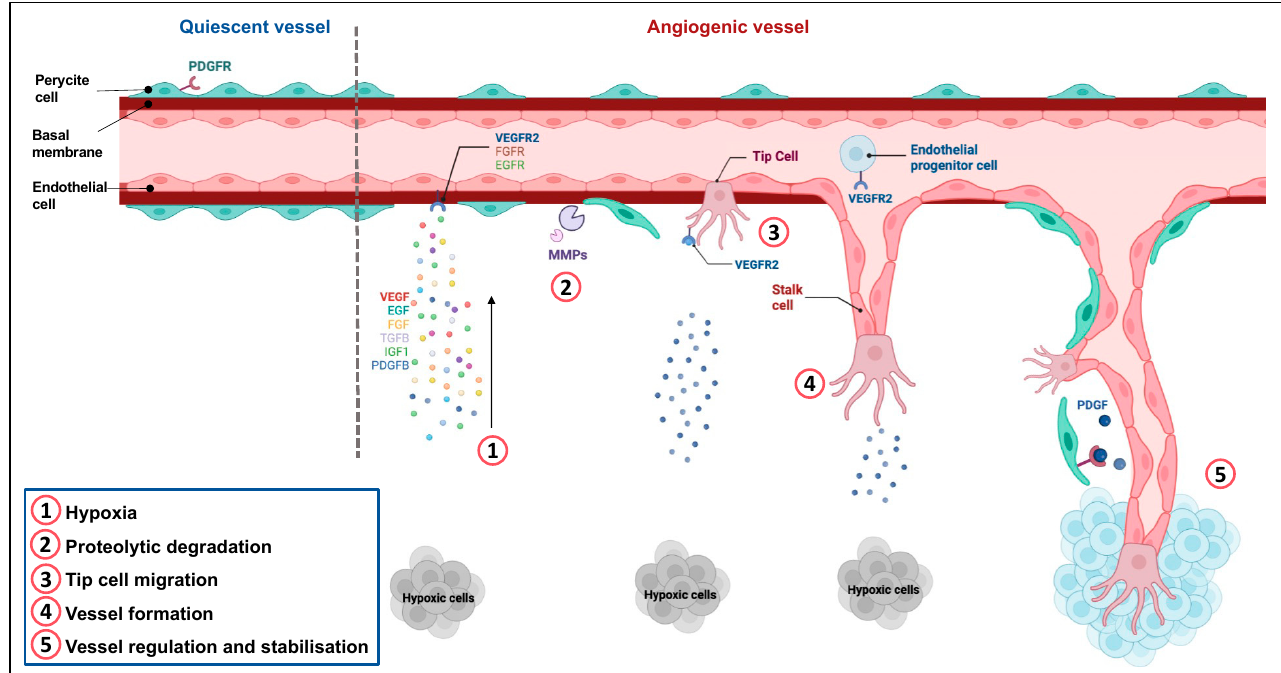
Figure 1. Regulation of angiogenesis. Quiescent ECs form a thin layer of single flat cells that line the interior surface of blood vessels and lymphatic vessels. These cells are interconnected by junctional molecules. EC monolayer is covered by pericytes, which control EC proliferation, release cell-survival signals and produce the basement membrane. 1. Hypoxia induces the secretion of pro-angiogenic factors. 2. This secretion leads to pericyte detachment, basement membrane degradation by metalloproteases and loss of EC junctions via VEGFR-2 activation. 3. One EC called tip cell is selected to guide elongation of the vessel towards proangiogenic signals. Remodeling of the existing matrix allows the migration of ECs. 4. Stalk cells proliferate and elongate to form a new vessel. 5. Following Dll4-Notch signaling and PDGF release, EC resume their quiescent state, the vessel is stabilized by recruitment of pericytes via PDGFR and deposition of a basement membrane. Adapted from “Tumor vascularization”, by BioRender.com (2022). Retrieved from https://app.biorender.com/biorender-templates (accessed on 4 December 2022).